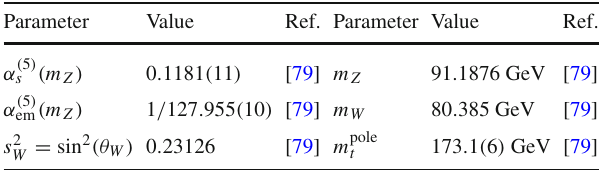
Table 4 Numerical input for Wilson coefficients Parameter